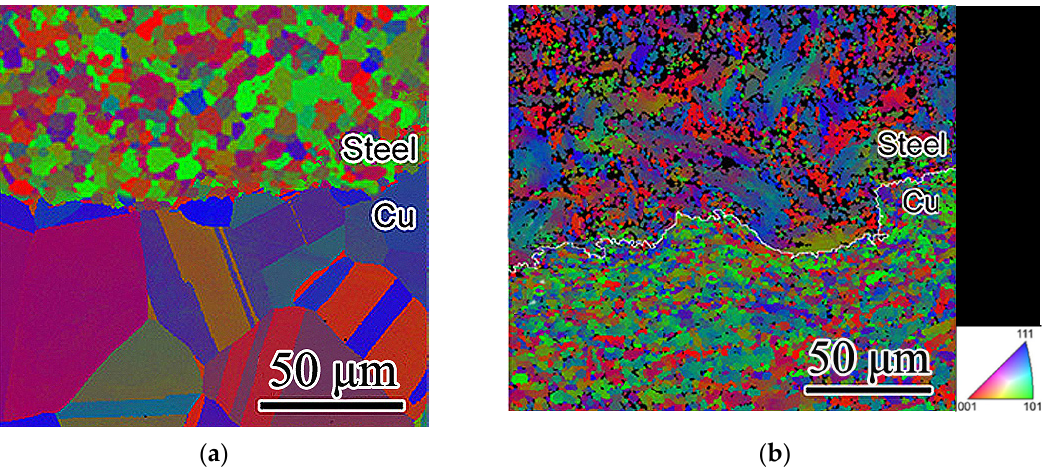
Figure 2. Microstructure orientation maps of steel-copper wire (transversal section): ( a ) initial state; ( b ) after three passes by ECAP-drawing.